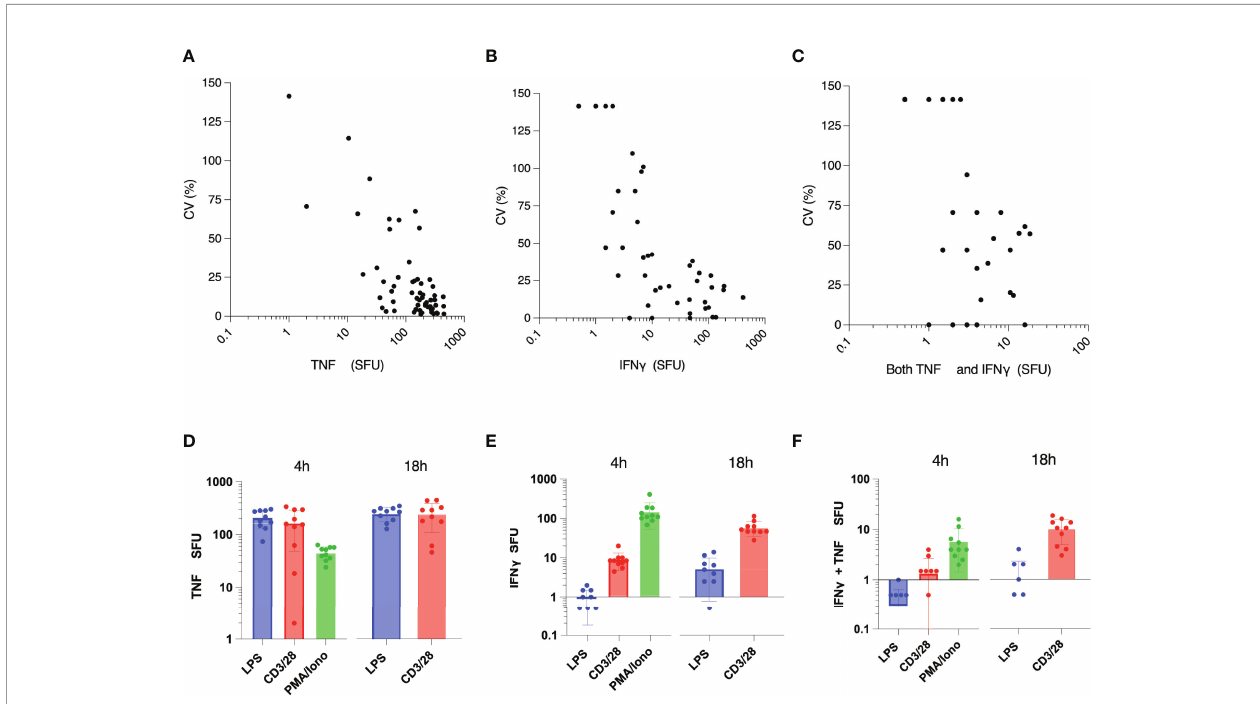
FIGURE 1 | Intra-assay variability of ELISpot immunoassay, assessed by percentage coef fi cient of variation (CV) for: (A) Tumor Necrosis Factor (TNF), (B) Interferon (IFN) g , and (C) dual-staining cells (both IFN g and TNF). (D) TNF, (E) IFN g , and (F) dual-cytokine production following ex vivo stimulation with various immune stimulants (x-axis) for 4 hours or 18 hours. N = 2 for each measured analyte. 18 hour ELISpot data includes response to LPS and anti-CD3/anti-CD28 only, due to cell over-stimulation with PMA. SFU, spot forming